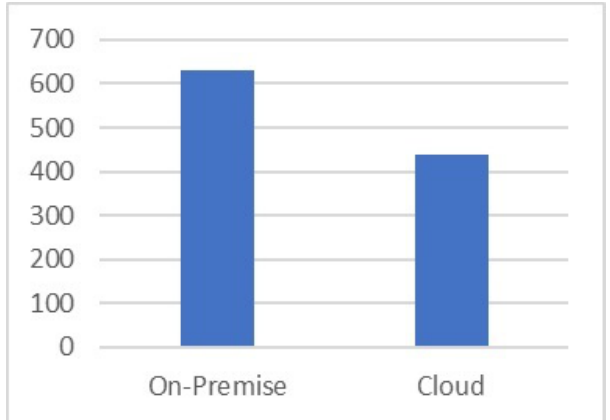
Figure 1. Cost of Ownership - On-Premises vs. Cloud ($ per Core per